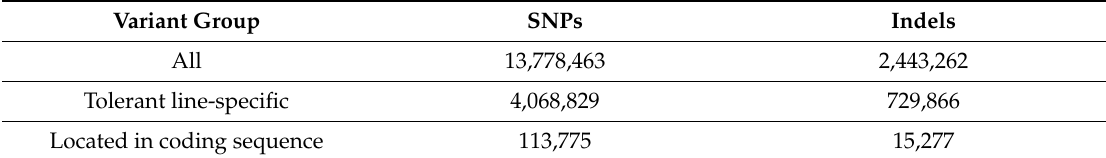
Table 2. Summary of identified small variants from Illumina